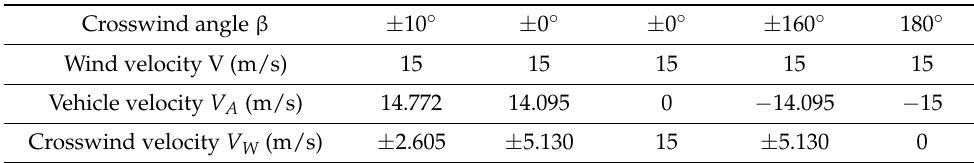
Table 6. Data of downflow velocity, vehicle velocity and crosswind velocity at crosswind angle in crosswind simulation part.